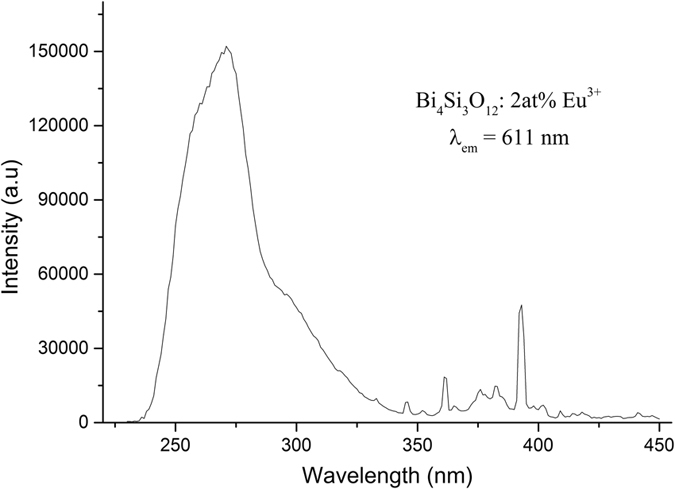
Excitation spectra of Bi4Si3O12: 2 at% Eu3+ phosphors at room temperature.